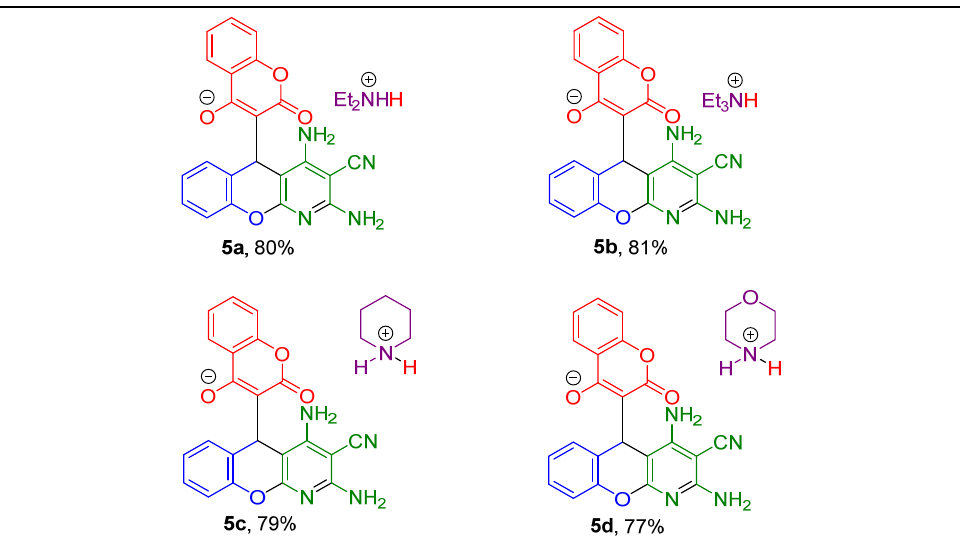
Table 1. Four-component reaction of salicylaldehyde 1 , 2-aminoprop-1-ene-1,1,3-tricarbonitrile 2 ,